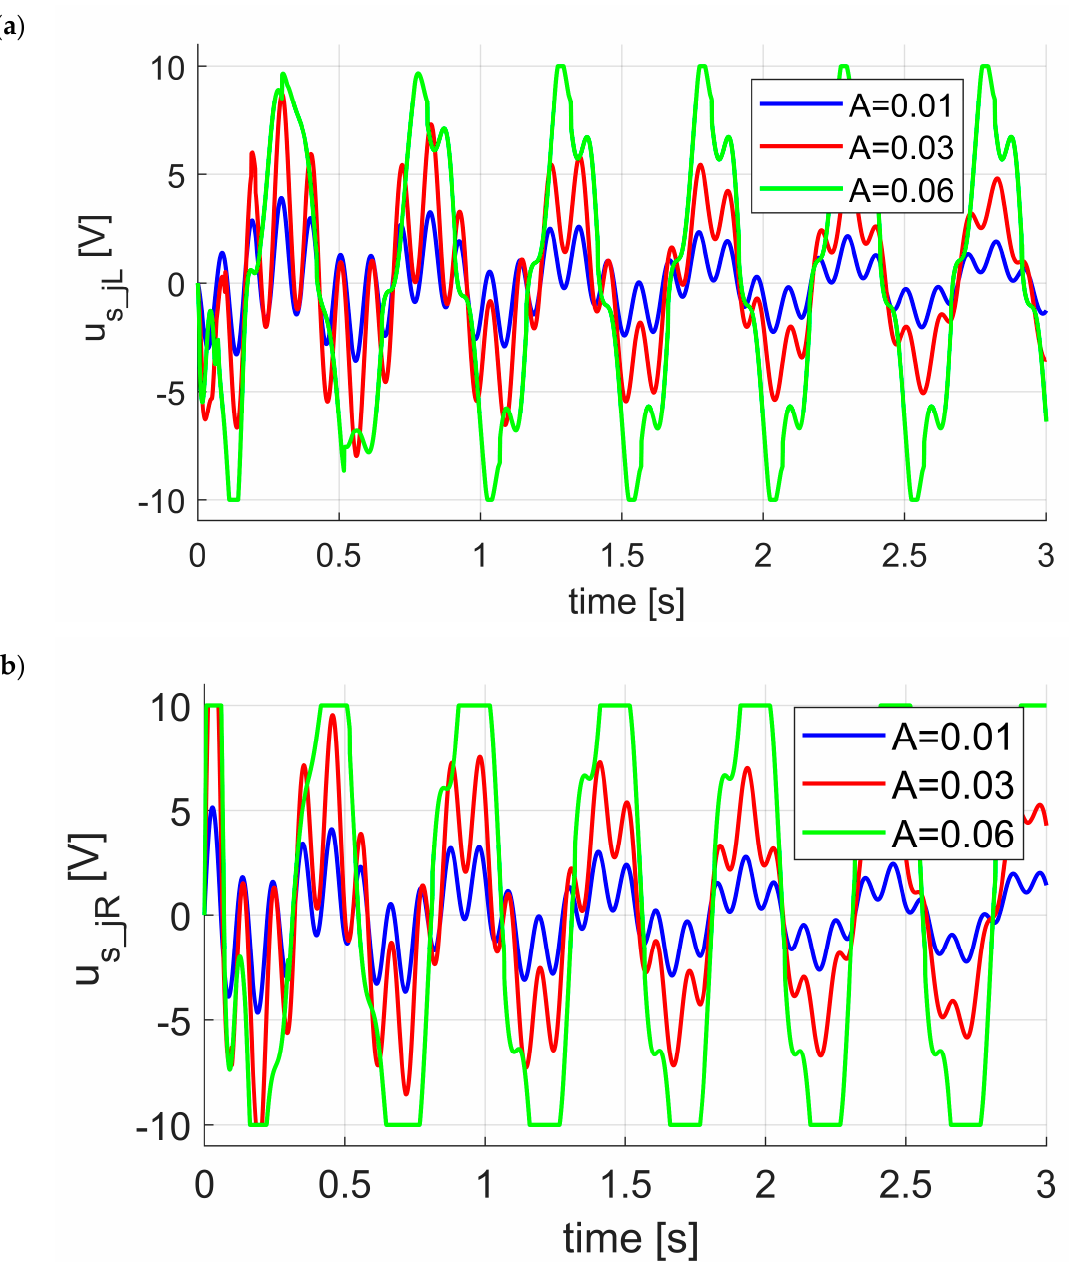
Figure 8. Time courses of the left strut control signal ( a ) and right strut control signal ( b ) for the three different amplitudes of the road disturbances.